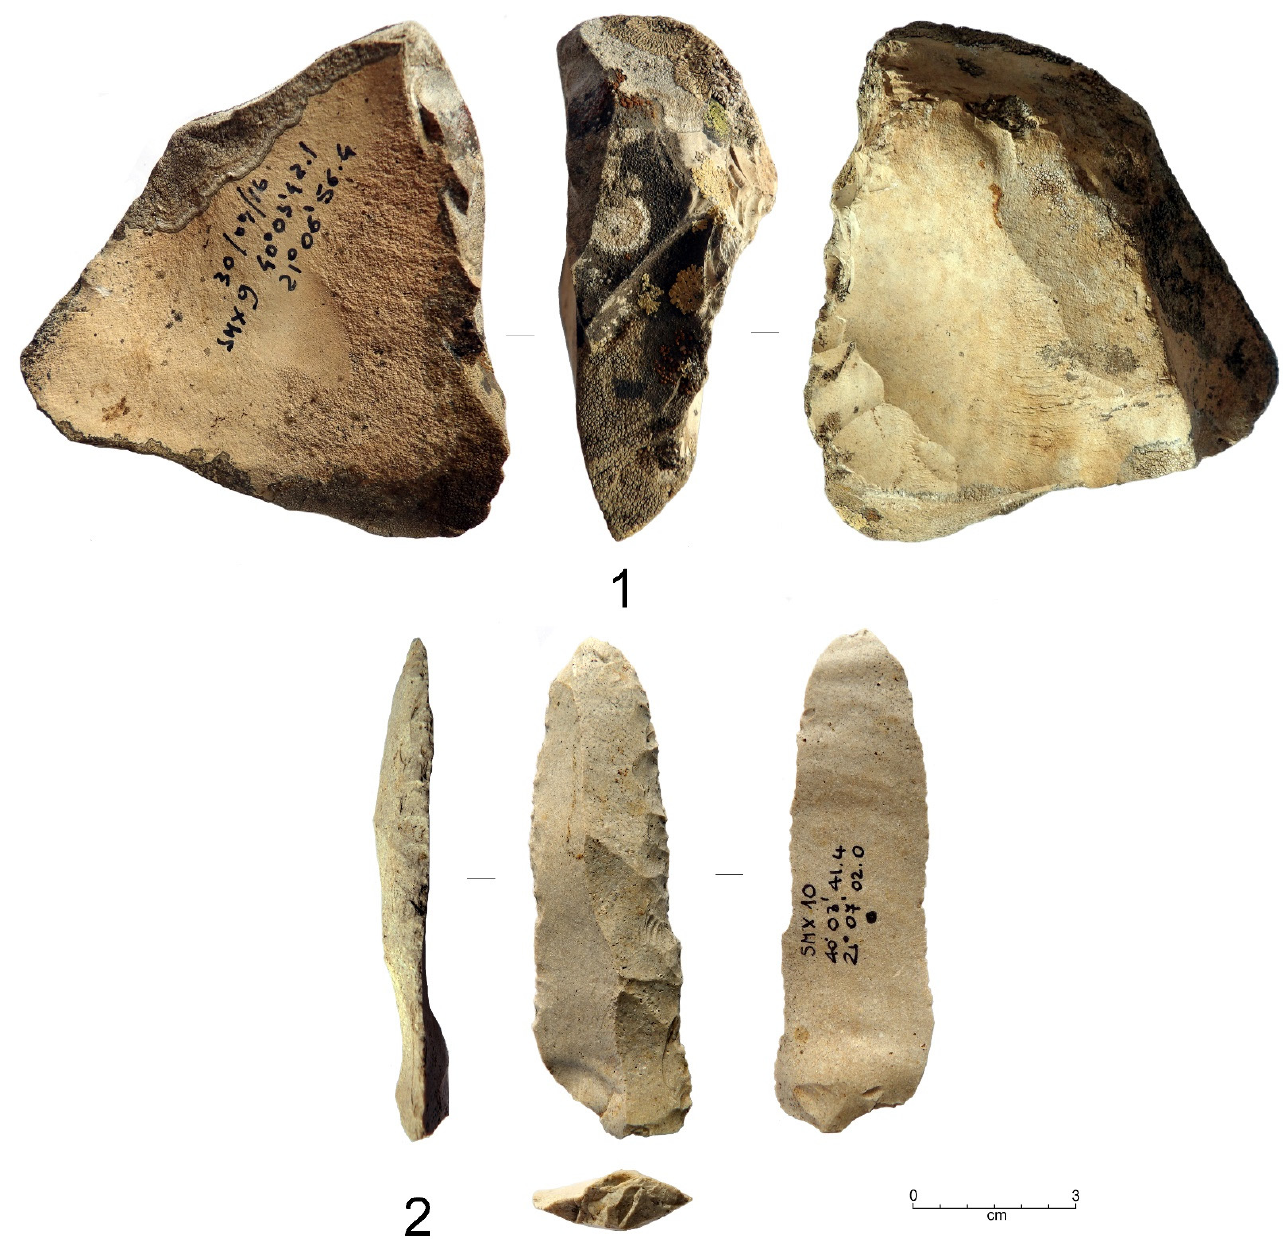
Figure 21. Lake Smixi: Middle Palaeolithic pre-core (n. 1) and probable Upper Palaeolithic point on a blade (n. 2) made from local chert (photographs by E.